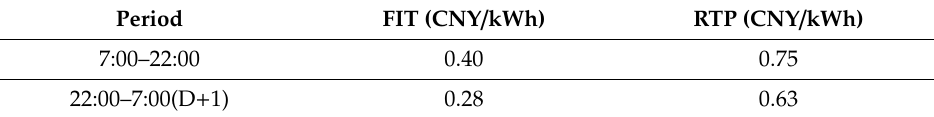
Table 2. Real-time price (RTP) and feed-in tari ff (FIT) in the day-ahead market.